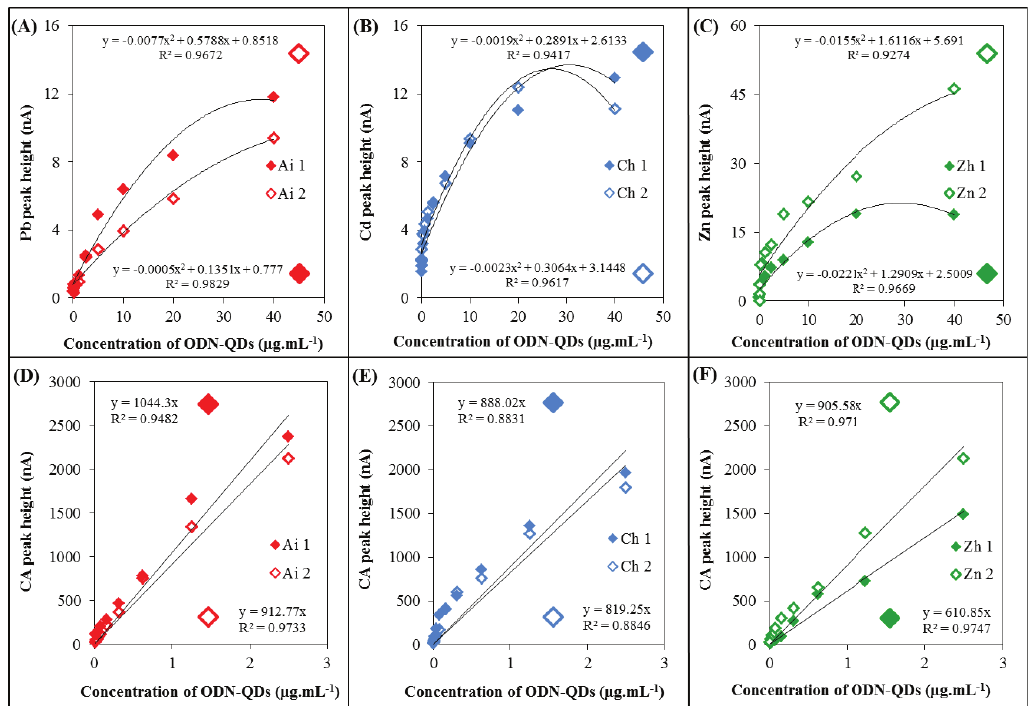
Figure 4. Calibration curves of metal and CA peaks. ( A – C ) Dependences of height